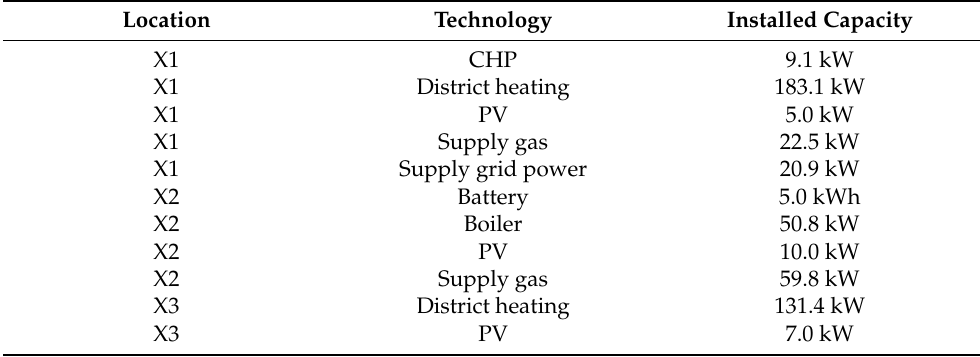
Table 4. The Calliope planning mode results, used as inputs for the Calliope operational mode and